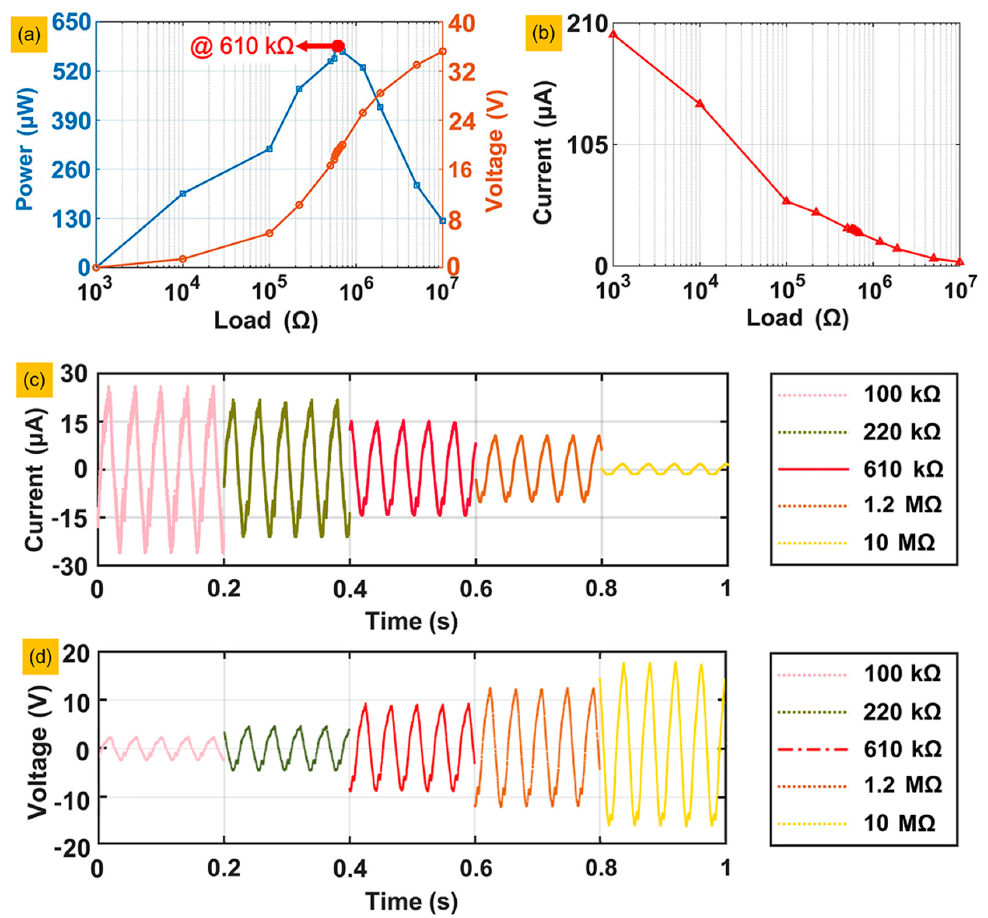
Figure 8. The power, output voltage and current of piezoelectric layer number 1 matching different impedances: ( a ). The power and output voltage curves. ( b ). The current curve. ( c ). Current signals under different circuit load conditions. ( d ). Voltage signals under different circuit load conditions.